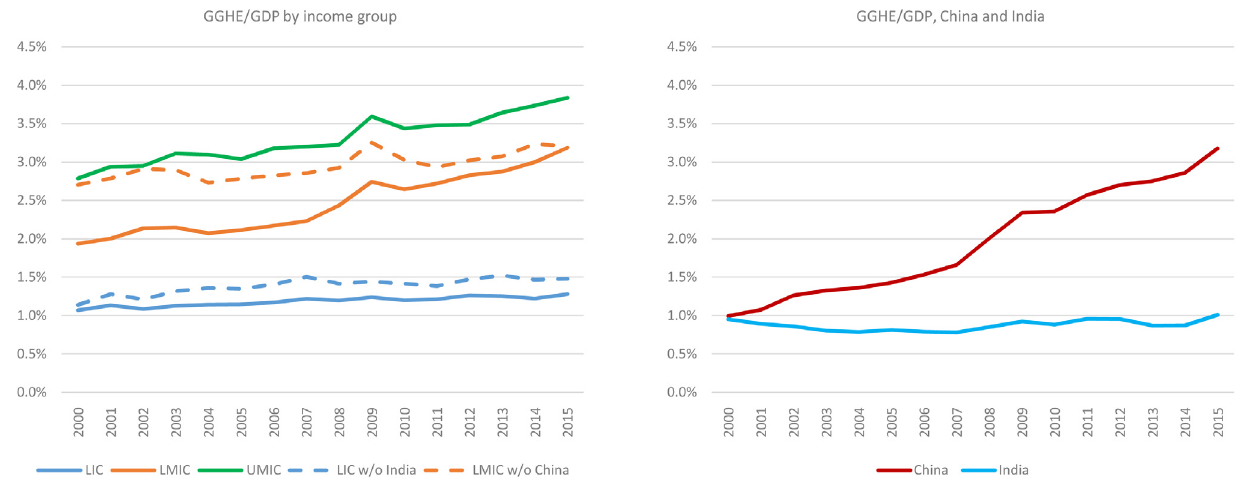
Figure 5. General government expenditure on health (GGHE)/ gross domestic product (GDP) by income group, and separately for China and India, 2000 to 2015.